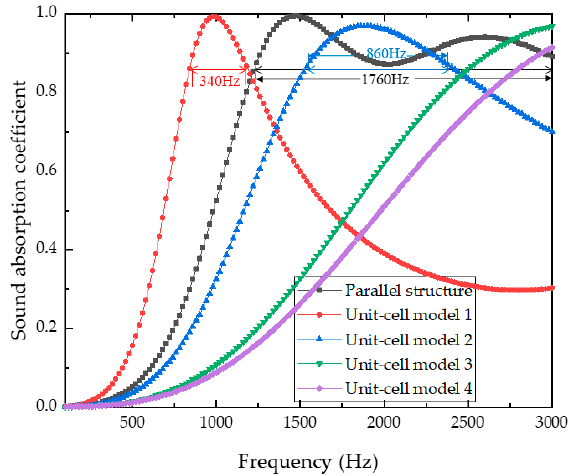
Figure 16. Comparison diagram of the parallel model and unit ‐ cell model.